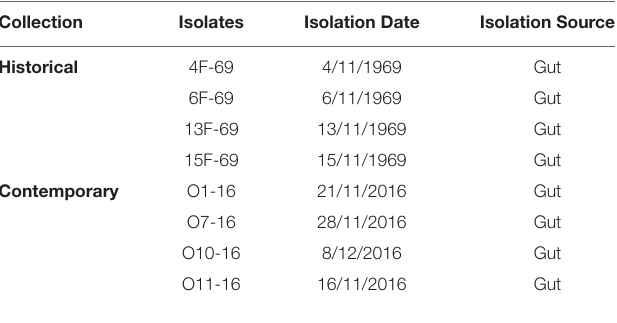
TABLE 1 | Isolation date and source of the eight Serratia marcescens studied isolates.